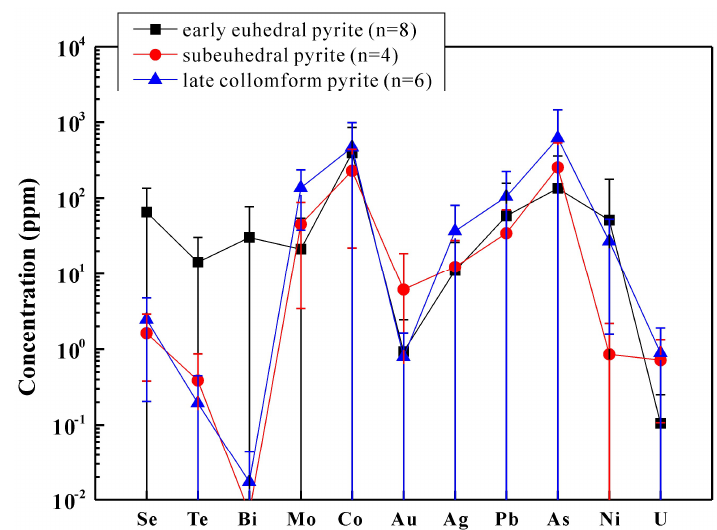
Figure 6. Average trace element concentrations in different pyrite types of the Kairei vent field.